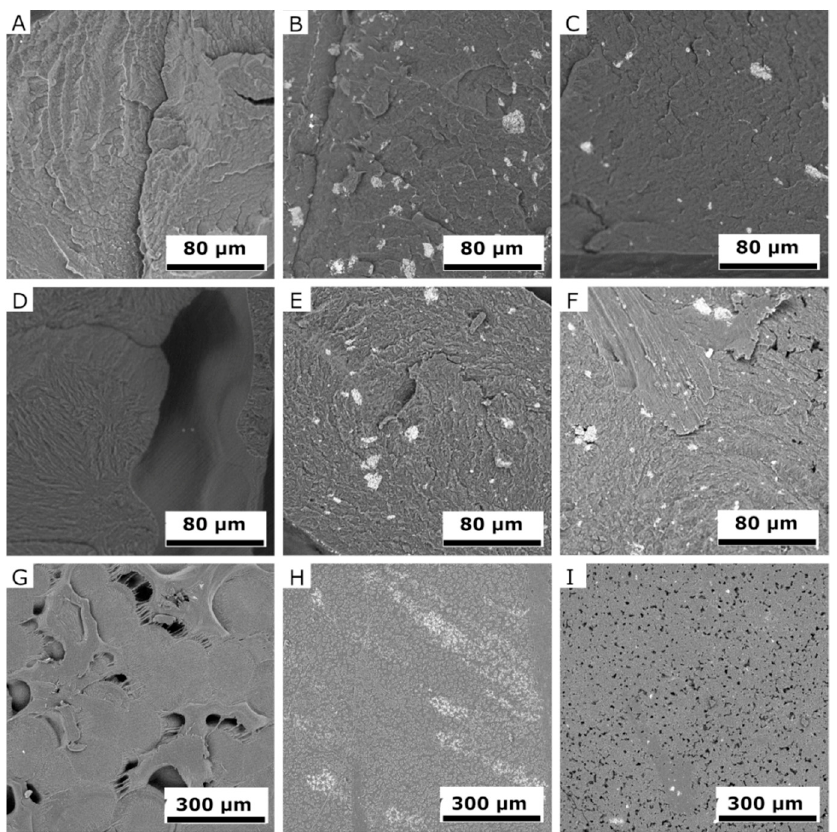
Figure 14. SEM images detailing change in the PCL samples prior to and following exposure in a UV chamber: the fracture surfaces of samples ( A ) PCL, ( B ) PCL-BE, ( C ) PCL-BRE, ( D ) PCL-UV, ( E ) PCL-BE-UV, and ( F ) PCL-BRE-UV; and the surfaces of samples ( G ) PCL-UV, ( H ) PCL-BE-UV, and ( I ) PCL-BRE-UV.